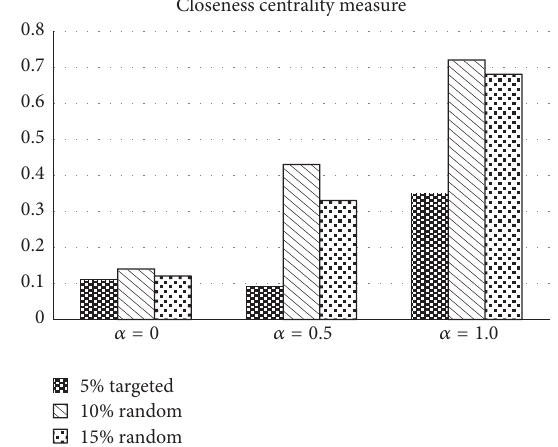
Figure 4: Targeted versus random removal of links (by Closeness centrality measures).